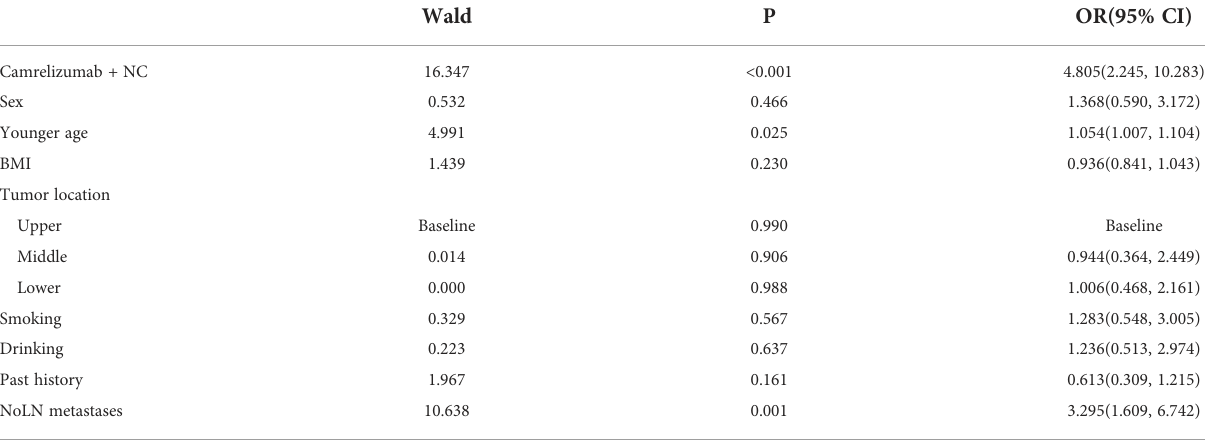
TABLE 5 Logistic model of factors increasing the likelihood of patients achieving a